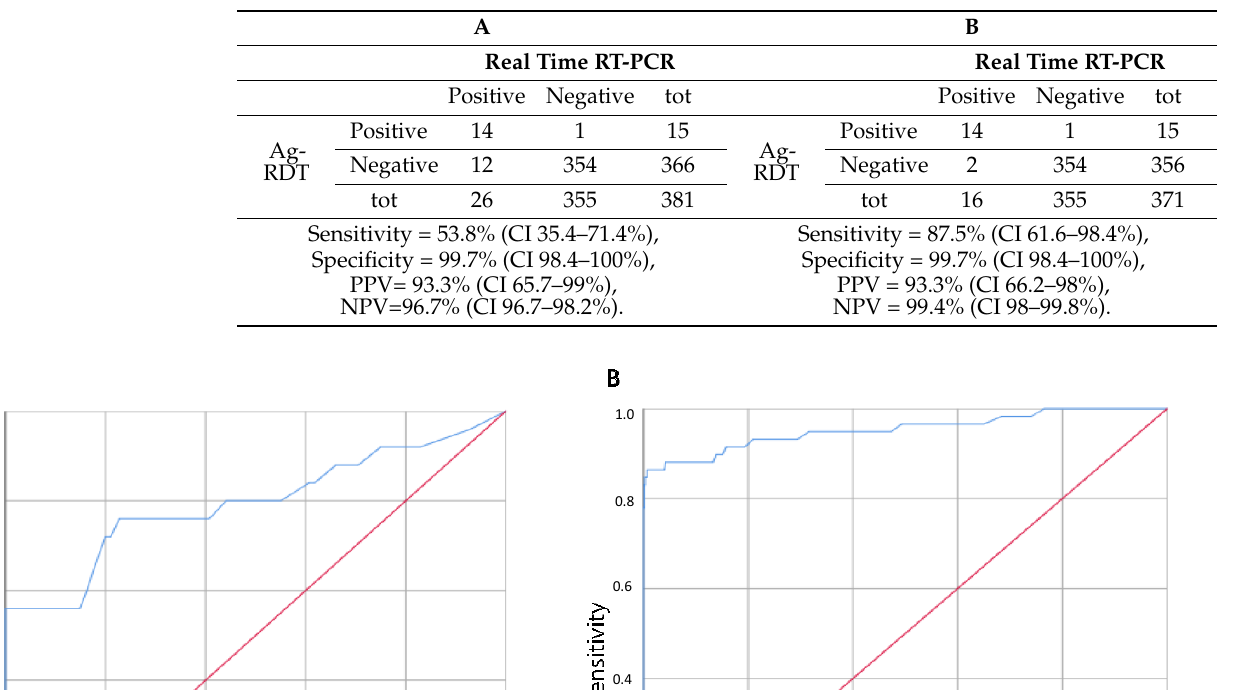
Table 3. Cross-table, sensitivity, specificity, positive predictive value (PPV), negative predictive value (NPV) for COVID-19 Ag FIA Ag-RDT.